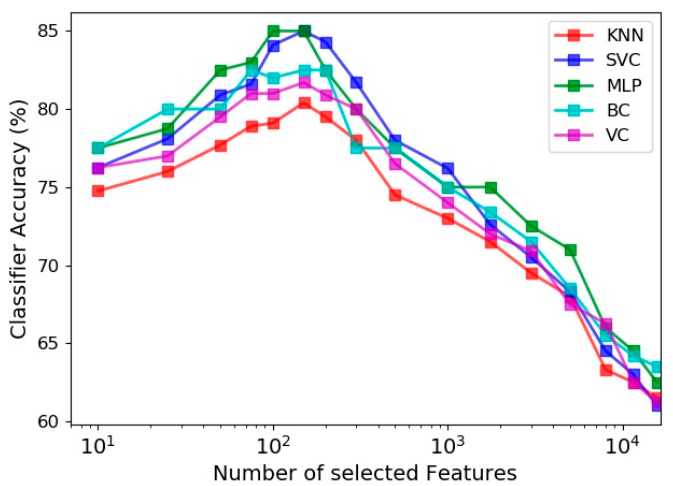
Figure 9. Effect of number of features selected by feature importance on the accuracy of different classifiers.